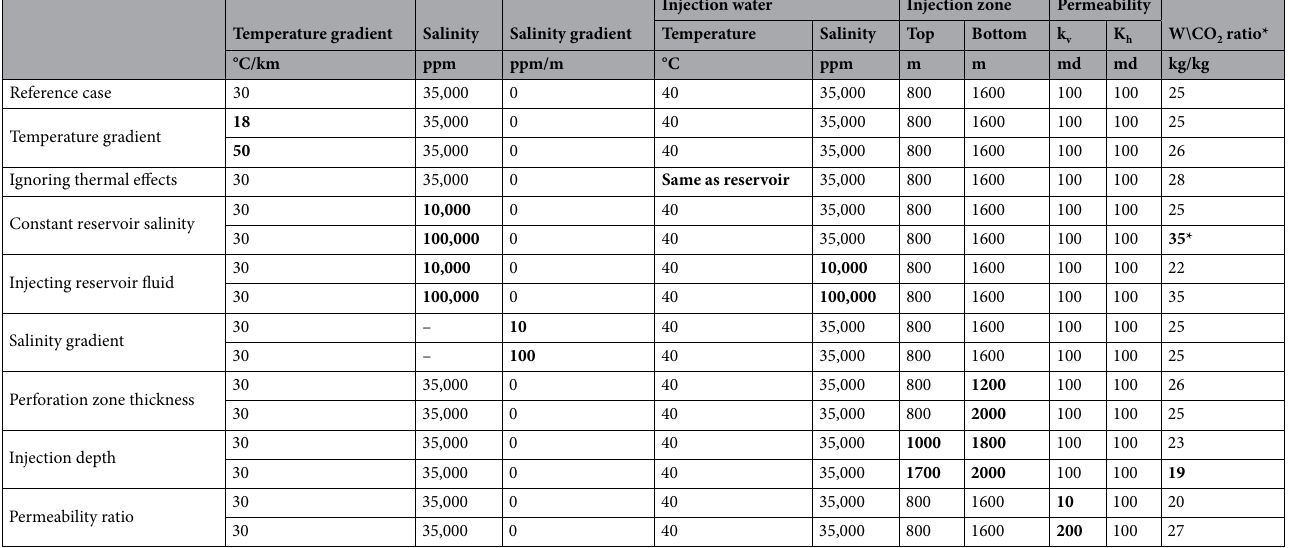
Table 1. Model parameters and their impact on solubility storage potential. Significant values are in bold. *The water to CO 2 ratio was fixed to be the minimum value without allowing CO 2 to escape to the surface within 100 years of carbonated water while injecting 100,000 metric tons CO 2